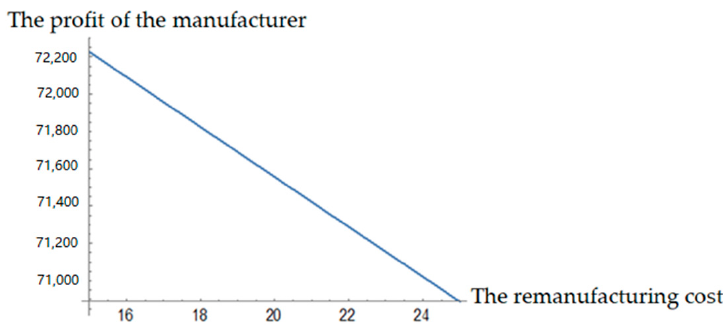
Figure 3. Effects of remanufacturing cost on the manufacturer’s profit.